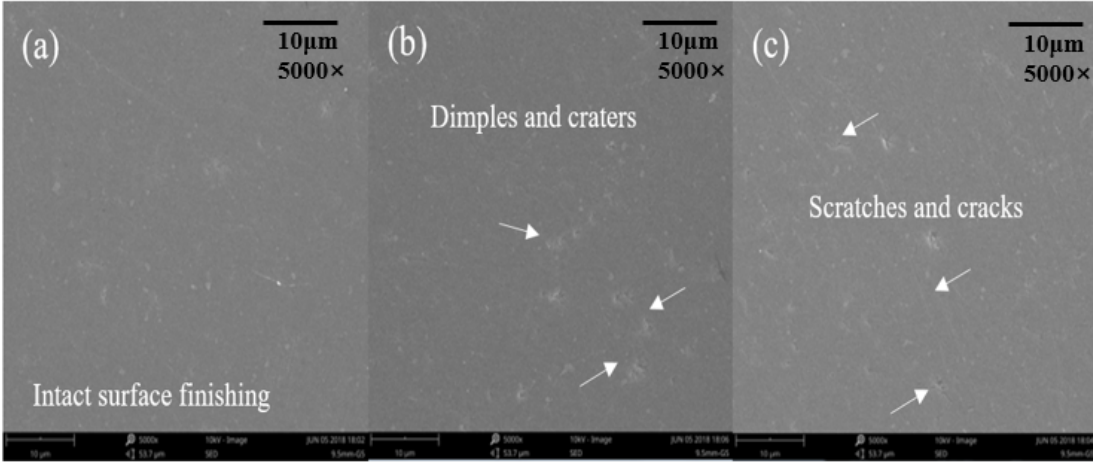
Figure 5. Miro morphology (5000 × ) of the polished surface ( a ) the surface of Test 9, ( b ) the surface of Test 6, ( c ) the surface of Test 3.